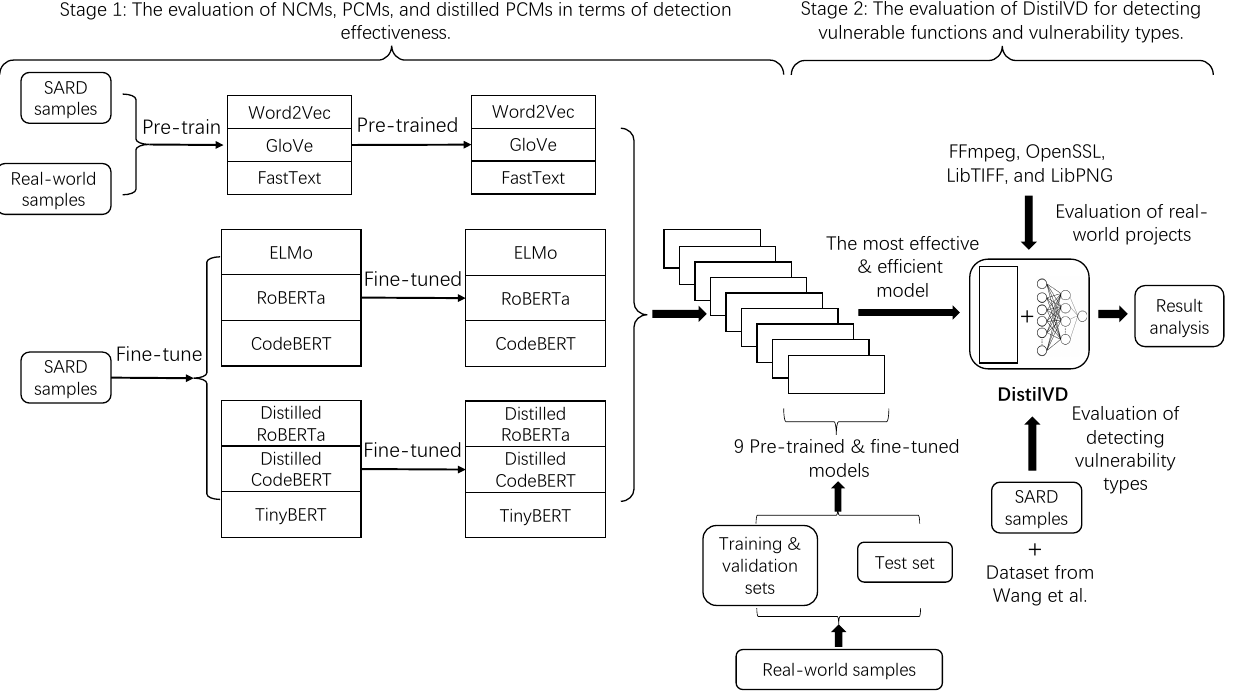
Figure 3. The workflow of the evaluation and the design of the framework, consisting two stages. Stage 1 evaluates NCMs, PCMs, and distilled PCMs in terms of their detection effectiveness. Stage 2, based on the evaluation of Stage 1, the best-performed models are selected for efficiency